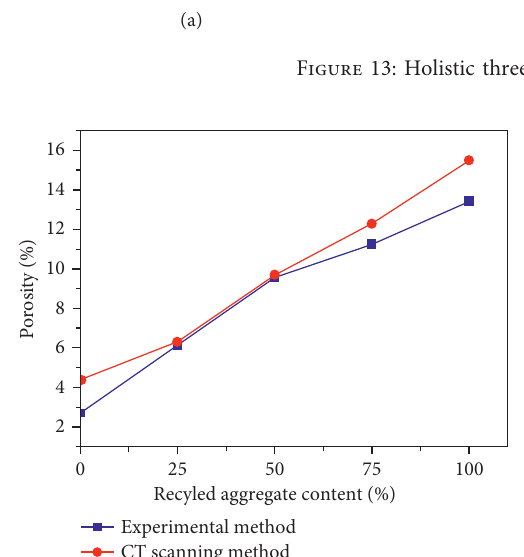
Figure 14: Comparison of porosity obtained from the new method and CT scanning.